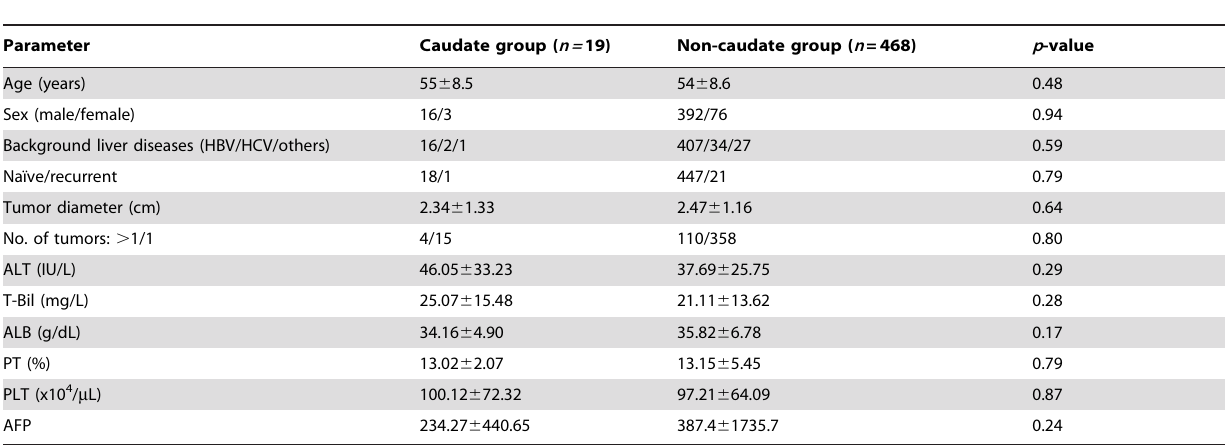
Table 3. Comparison of baseline factors between the caudate group and the non-caudate group.